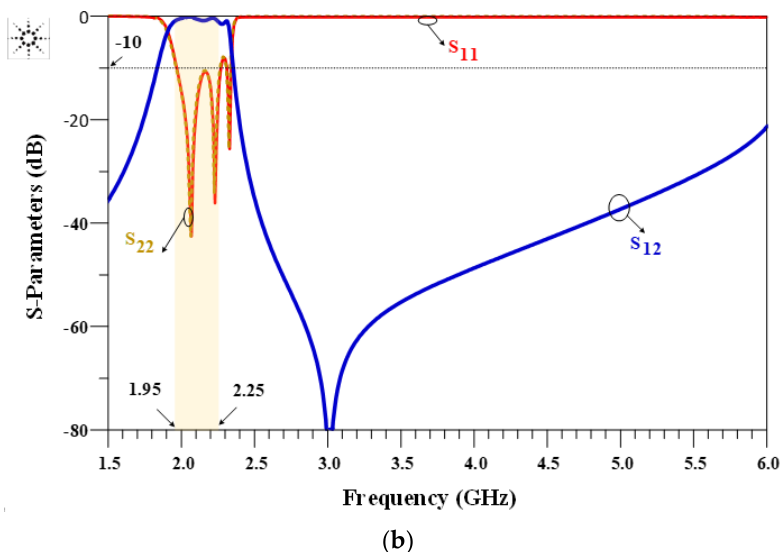
Figure 8. Designed 2.1 GHz filter. ( a ) Circuit structure, and ( b ) S-parameters simulated frequency response (dimensions are in mm).